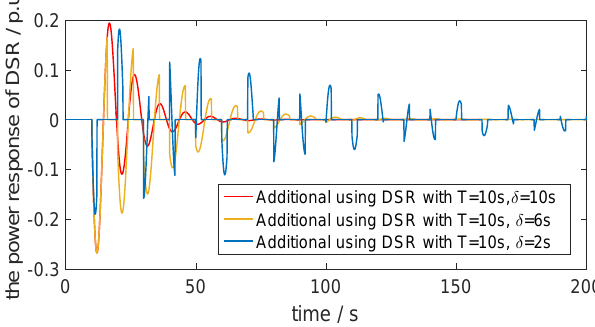
Figure 7. The response power of DSRs under different intermittent control parameters.